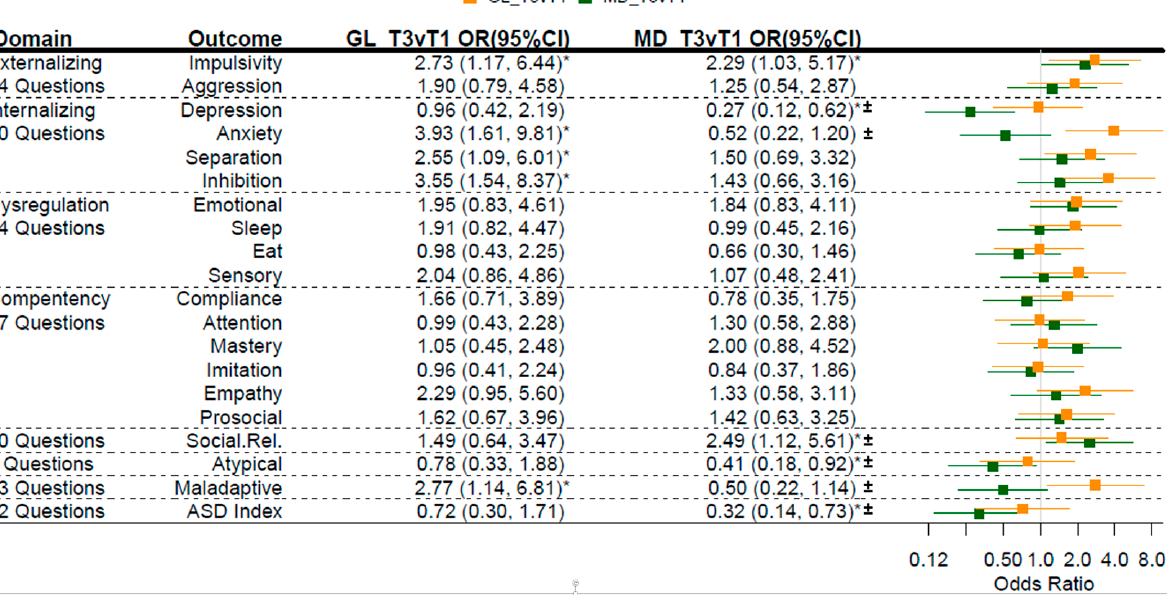
Figure 5. Concurrent modeling of MGL and Mediterranean dietary adherence on offspring temperament. For the 3rd tertile of MGL compared to the 1st (referent), the odds ratio (95% confidence interval) represents the risk of being in a higher tertile of behavioral outcome. Odds ratios (95%CI) are plotted for glycemic loading (GL; orange) and Mediterranean diet (MD; green). Estimates were adjusted for breastfeeding at least 3 months, age of child at behavioral assessment, maternal fiber intake, total calories, folate, education, diabetes, obesity, smoking, race, and age, as well as child parity, premature birth, weight, and child sex. * p < 0.05; ± Previously reported significant when modeled without MGL as a concurrent predictor.